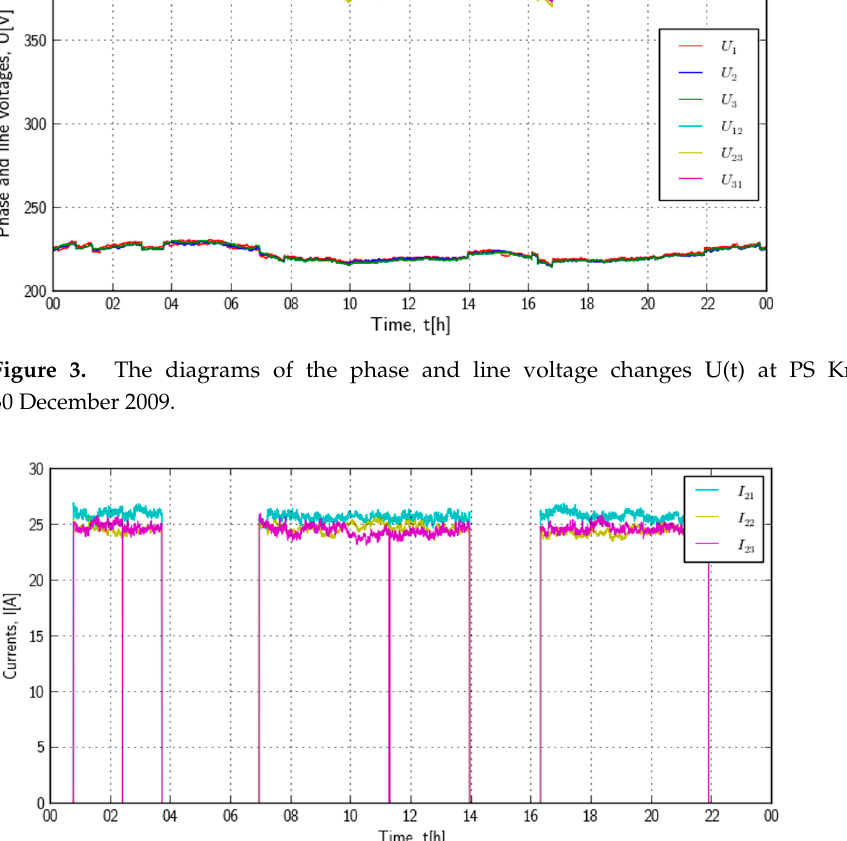
Figure 4. The diagrams of the PU2 load current changes I(t) on 30 December 2009.